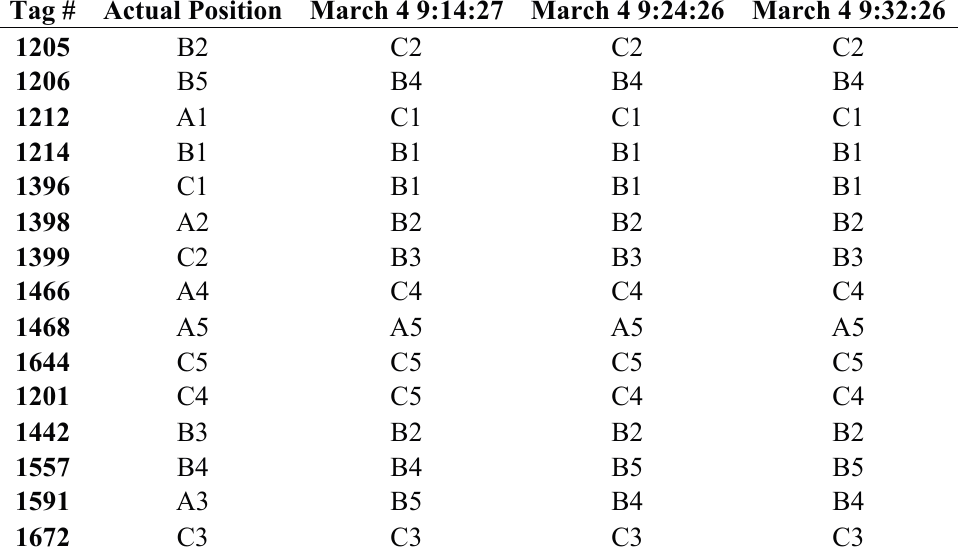
Table 2. Comparisons of the tags’ actual position and located by RFID using four readers at different times.